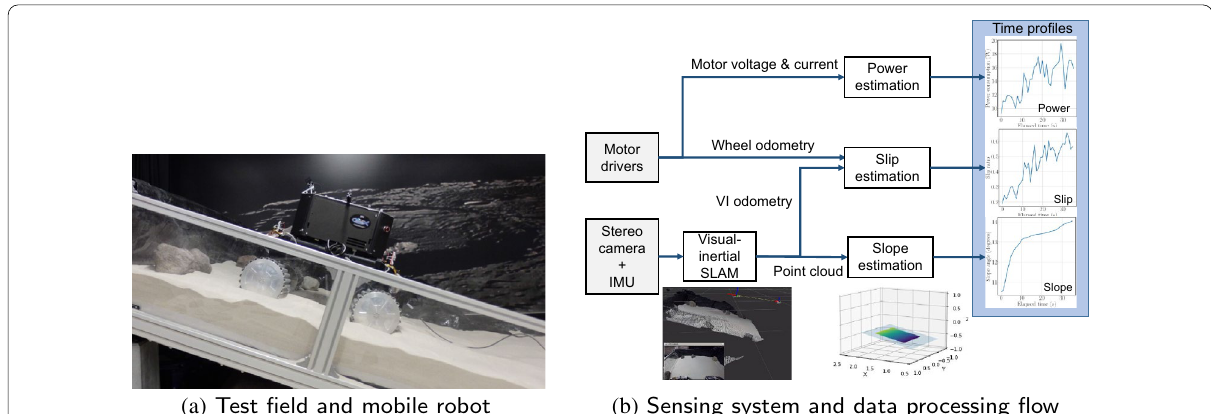
Fig. 3 Experiment system. The tiltable test field is covered with one of the surface materials in Fig. 4. The four-wheeled test vehicle is equipped with motor encoders, motor drivers, and a stereo camera with a built-in IMU for traverse data collection. The vehicle slip and terrain inclination are estimated from the wheel odometry and VI-SLAM. The electric power consumption of actuators is estimated from the voltage and current applied to the motors, which are monitored at the motor drivers